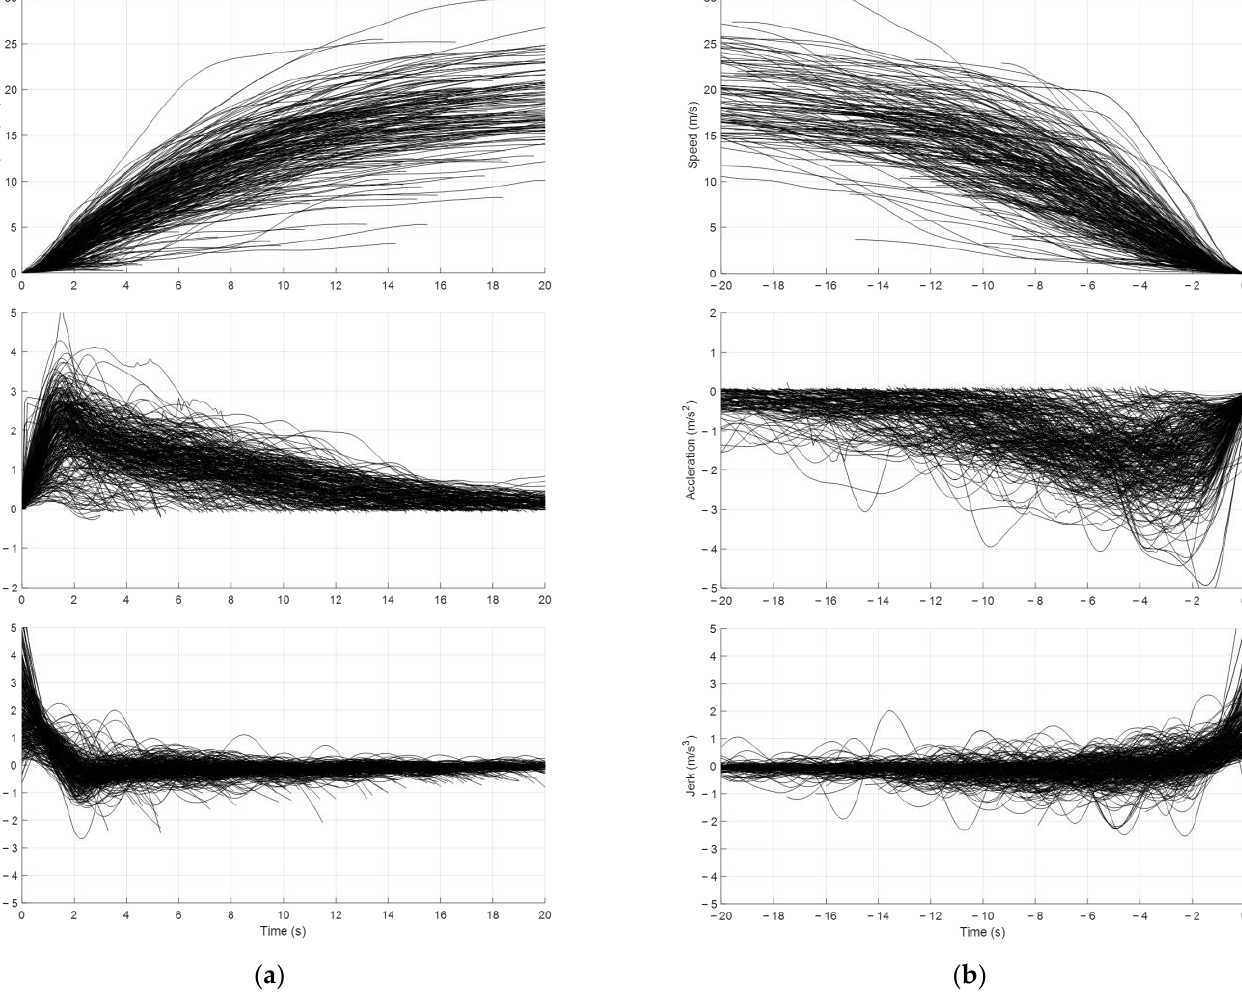
Figure A2. 300 randomly sampled data of free acceleration/deceleration situation from SPMD: ( a ) case of free acceleration; ( b ) case of free deceleration.